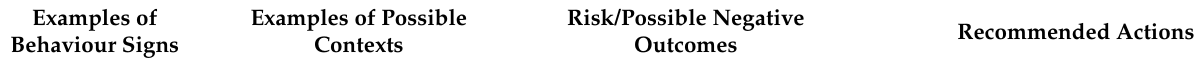
Table 4. Aggressive behaviour during corticosteroid treatment. Behavioural signs, examples of possible situations and contexts, possible outcomes, and recommended